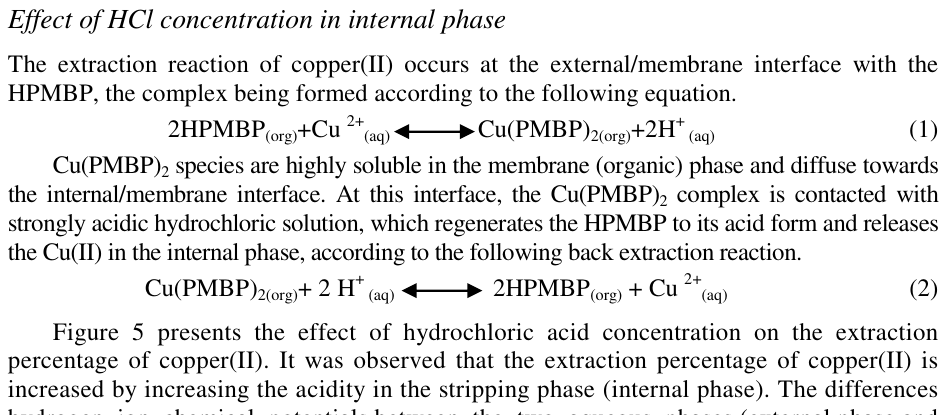
Figure 4. Effect of volume ratio Ve:Vex to extraction percentage of